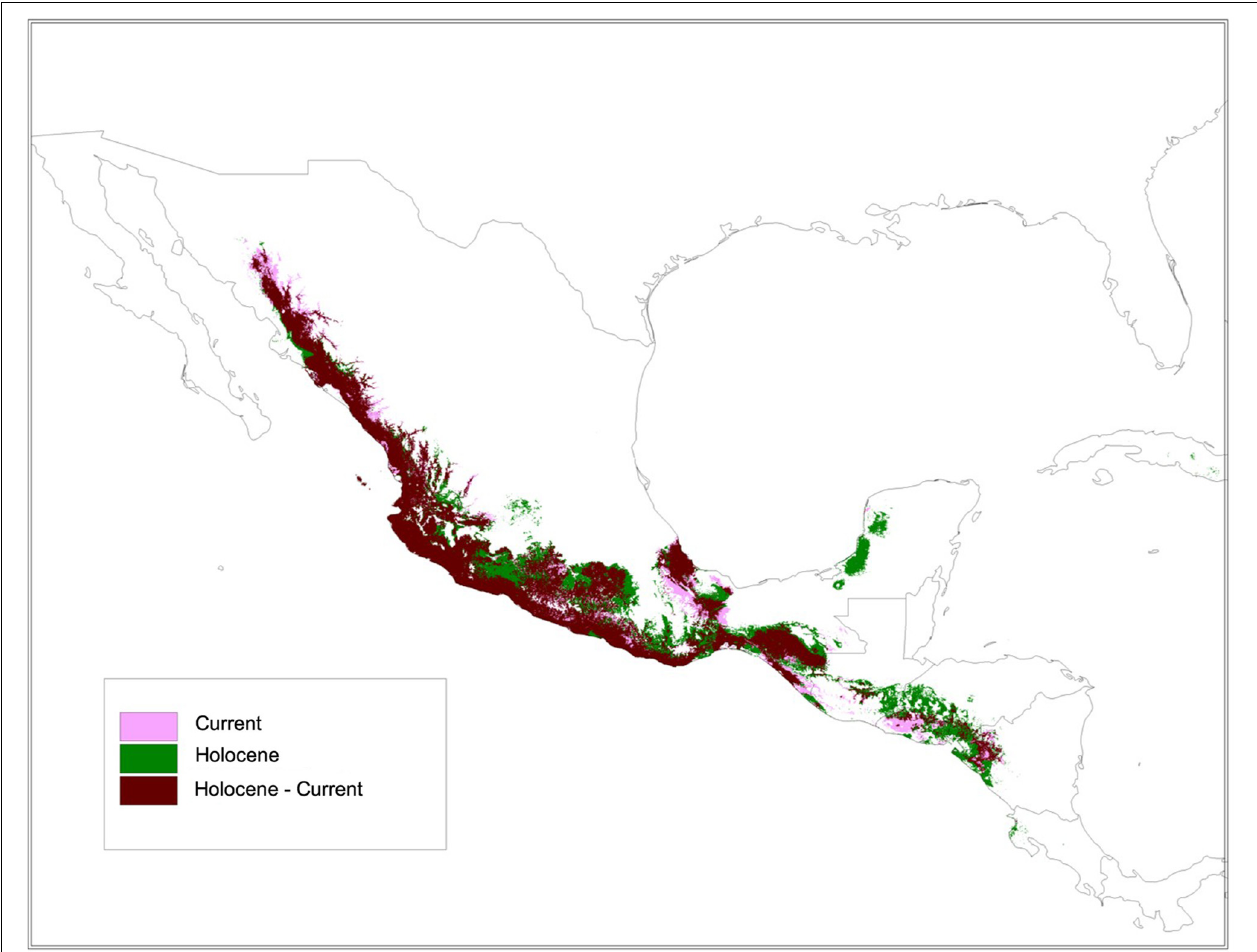
FIGURE 10 | The species distribution model (SDM) for ssp. sororia showed stability and good support (AUC: 0.96). Persistence during the mid-Holocene ( ∼ 6000 years ago) and present time in light persistence only in the Holocene in purple; and persistence only in the present in green.